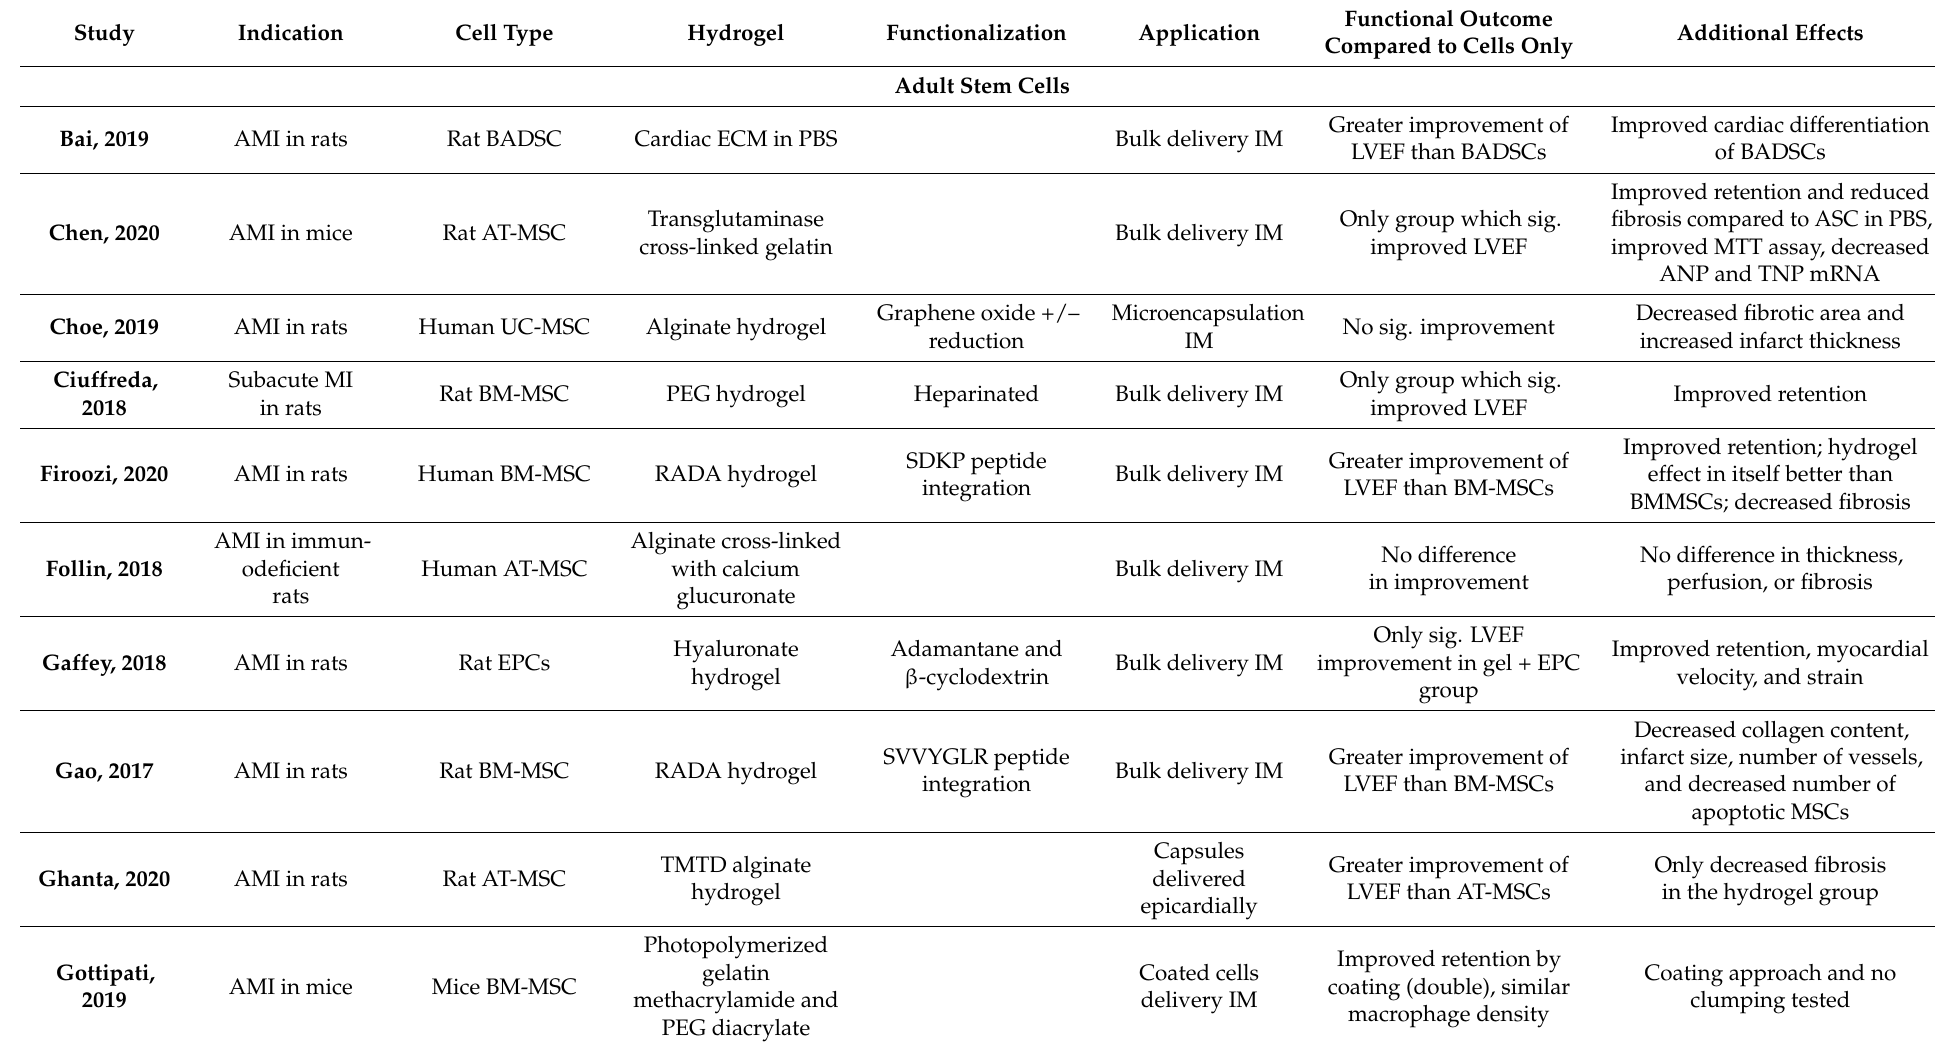
Table 2. Preclinical studies using hydrogel delivery of cell therapeutics since